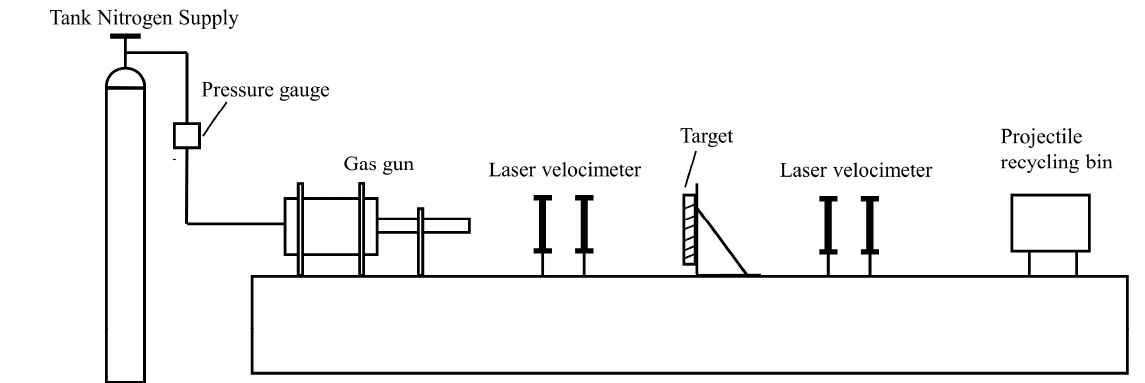
Figure 12. Schematic illustration of high-speed impact device.